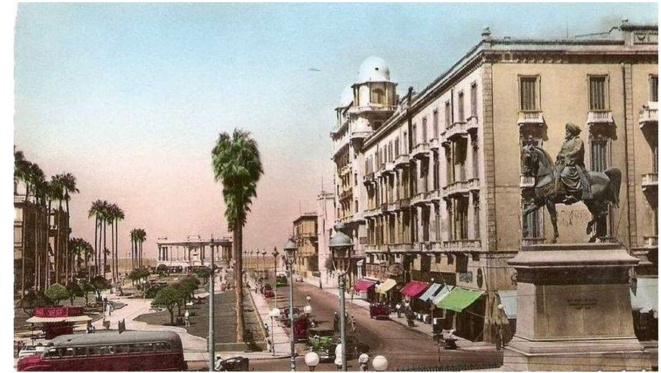
Figure 8. French Gardens photo 1931. Source: